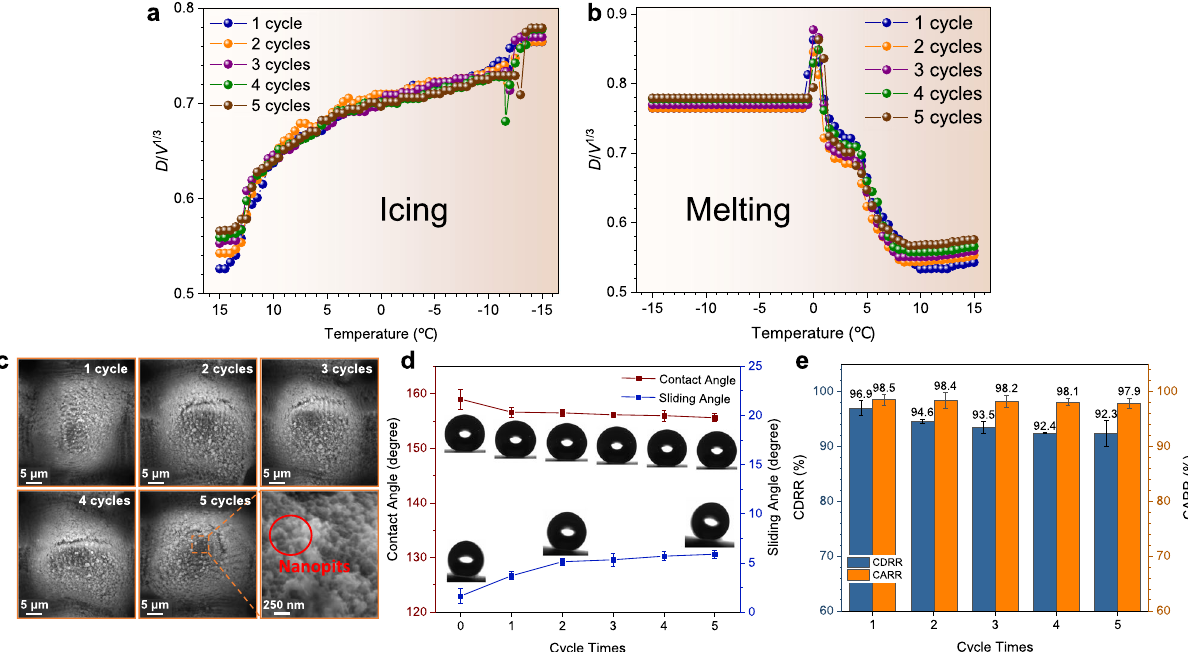
changes of the same droplet on the same location with the temperature decrease after 1 – 5 Fig. 10 Robustness tests of the W2C transition. a The D V 1 3 cycles. It corresponds to the icing process. D represents the contact diameters of droplets while V represents the droplet volumes. b The D change of the V 1 3 same droplet on the same location with increasing temperature after 1 – 5 cycles. It corresponds to the melting process. c Evolutions of surface micro-nano structures after multiple cycles. The formed nanopits are noted by the red circle. Cycle times and scale bars are marked. d Evolutions of contact angles and sliding angles of the same dropl e t after multiple cycles. e The changes of the contact diameter recovery rates (CDRR) and the contact angle recovery rates (CARR) of droplets on the MCNP surface with the increase of cycle times. Data are mean ± s.d. from at least three independent measurements.